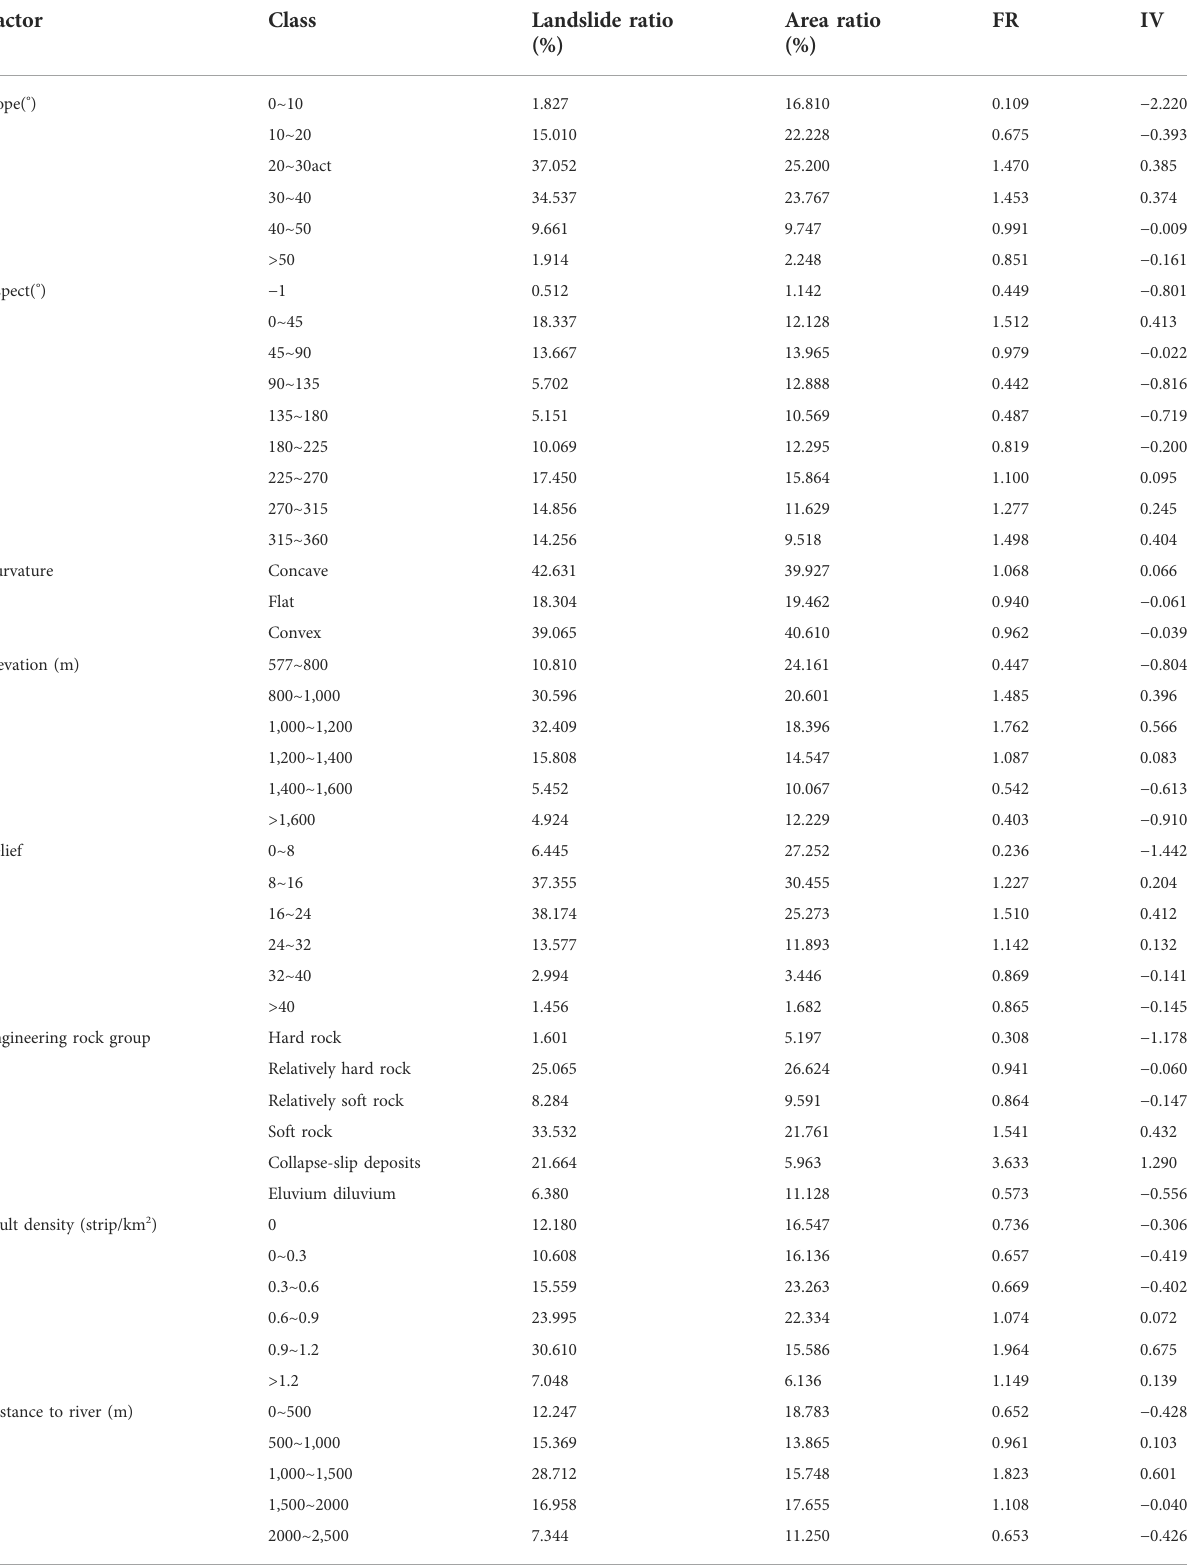
TABLE 1 Correlation values of mapping